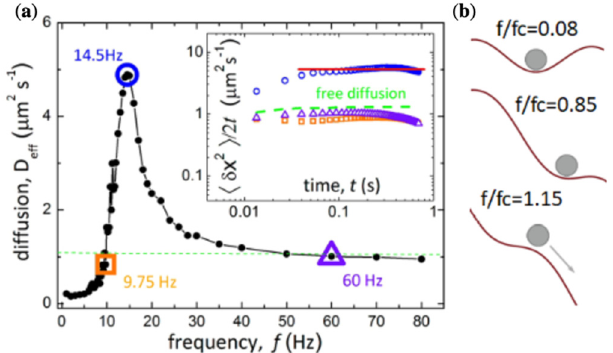
Figure 16. ( a ) Effective coefficient of diffusion D ef f measured across the domain walls of the ferrite garnet film (presented in Figure 15) as a function of the external field frequency for superparamagnetic particles with a diameter of 270 nm and susceptibility of 2. The field amplitude is 1200 A/m. The green dashed line represents the diffusion coefficient measured at a zero field. The frequency of the diffusion maximum f m = 14.5 Hz is close to the critical frequency f c = 13.4 Hz. The inset shows σ 2 x ( t ) /2 t for different frequencies marked in the main plot. The red line for f m is used to determine D ef f . ( b ) Schematic representation of the magnetic potential landscape for different frequencies. Reprinted with permission from ref. [72]. Copyright 2016, American Chemical Society.